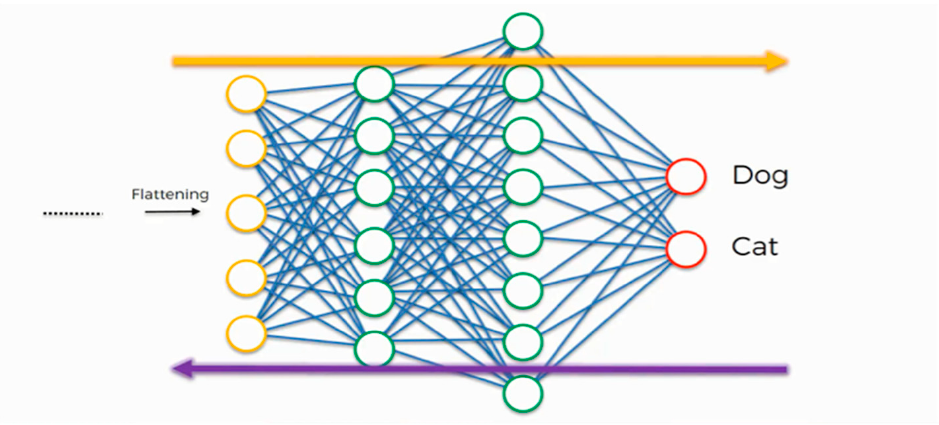
Figure 20. Full connection step with two neuron outputs (dog and cat) [57].